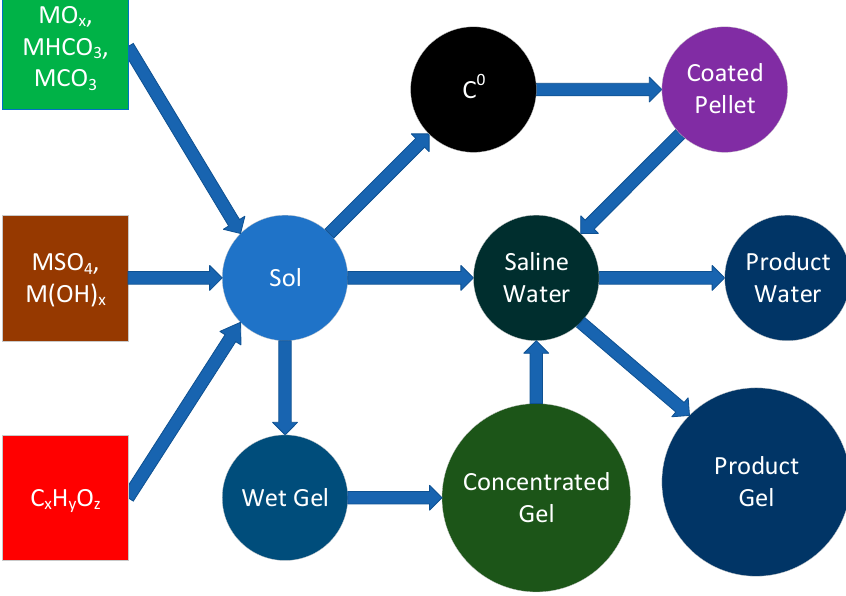
Figure 2. Summary of the Sol-Gel Approach used in this study.